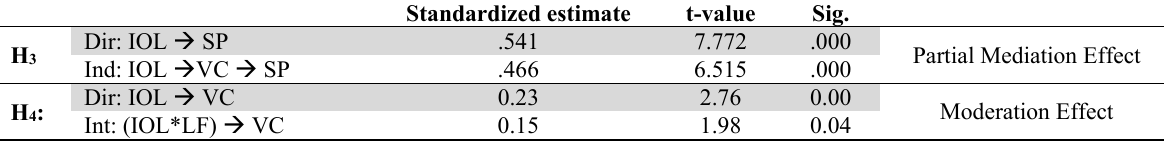
Analysis of mediator and moderator test results Standardized estimate t-value